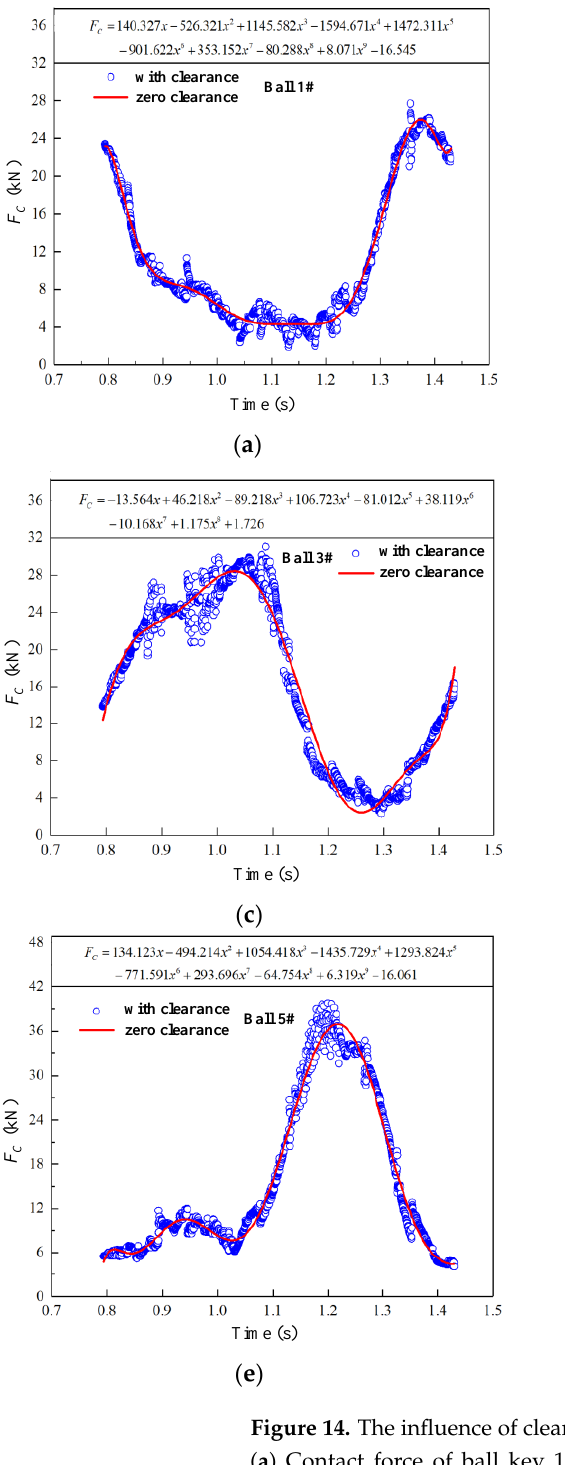
( b ) Figure 13. The influence of clearance on contact force between cage and ball seat. ( a ) The normal contact force (1.18 s – 1.82 s); ( b ) The axial contact force (1.52 s – 2.75 s). As shown in Figure 13, the effects of clearance on the contact force cannot be ignored. There will be repeated “contact -collision- separation” motion between the ball cage and groove, which is the main cause for the vibration of contact force. As shown in Figure 13a, the normal contact force amplitude between cage and ball seat is large, and the maximum value is 12.42 kN. There are many discrete points near the fitting curve and they are messy, which indicates that the clearance has a greater influence on the normal contact force. However, the discrete points near the fitting curve of the axial contact force of the cage are relatively concentrated, and the maximum amplitude of contact force is 1.68 kN, as shown in Figure 13b, which indicates that the clearance has little influence on the axial contact force. Figure 14 shows the variation of contact force between six ball keys and the ball seat with or without clearance. Due to the high coincidence between the ball seat groove and